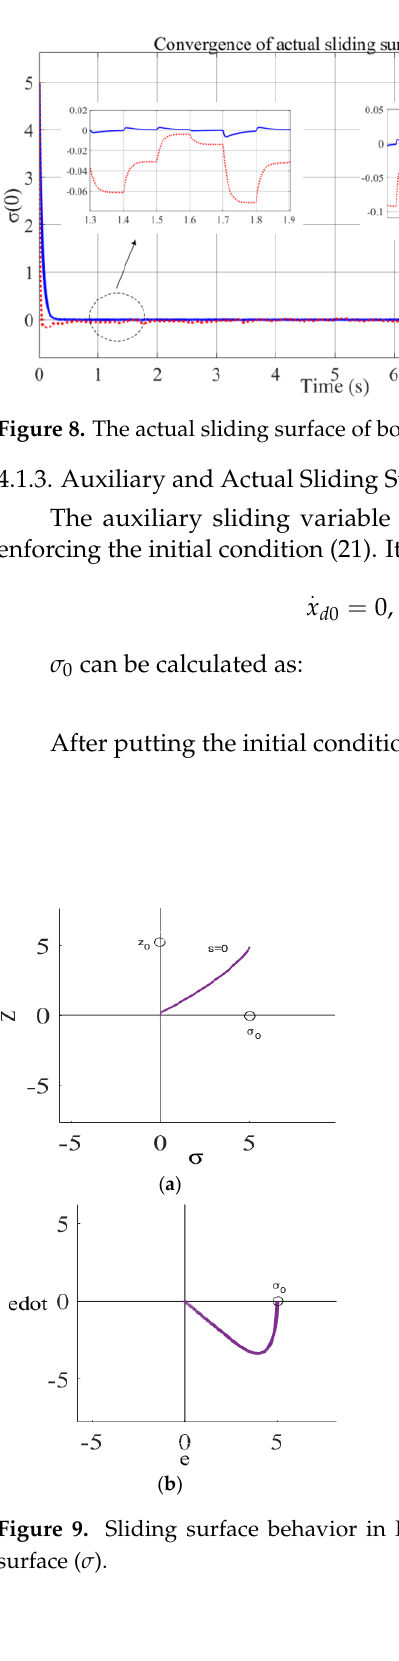
Figure 9. Sliding surface behavior in ISMC: ( a ) auxiliary sliding surface (s), ( b ) actual sliding sur- face ( 𝜎 ).